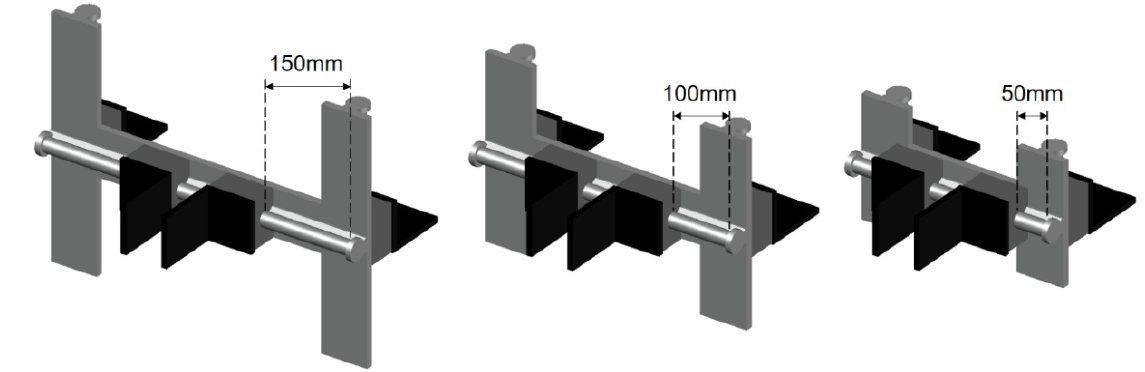
Figure 17. Designed model for each linear guide length.